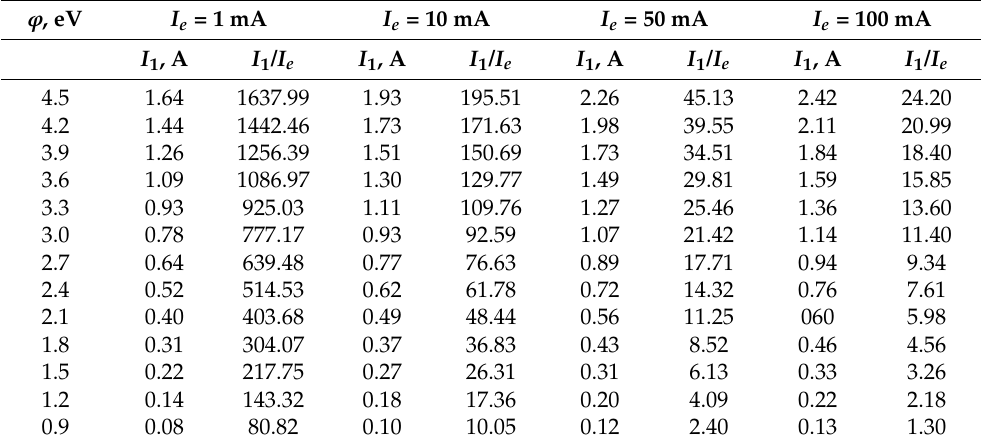
Table 1. The simulation results of the I 1 / I e quotient as a function of the electron work function ϕ , at the set values of the emission current: 1 mA, 10 mA, 50 mA, and 100 mA.